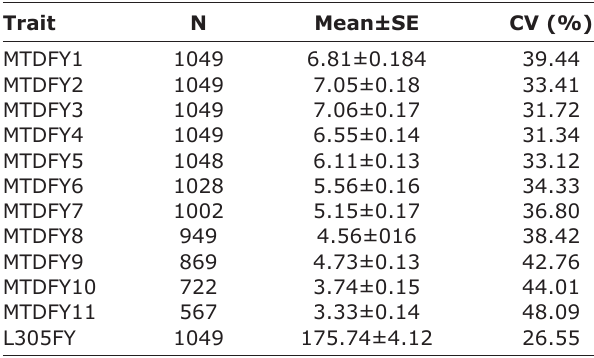
Table-1: Least squares means of L305FY and different MTDFY (in kg).